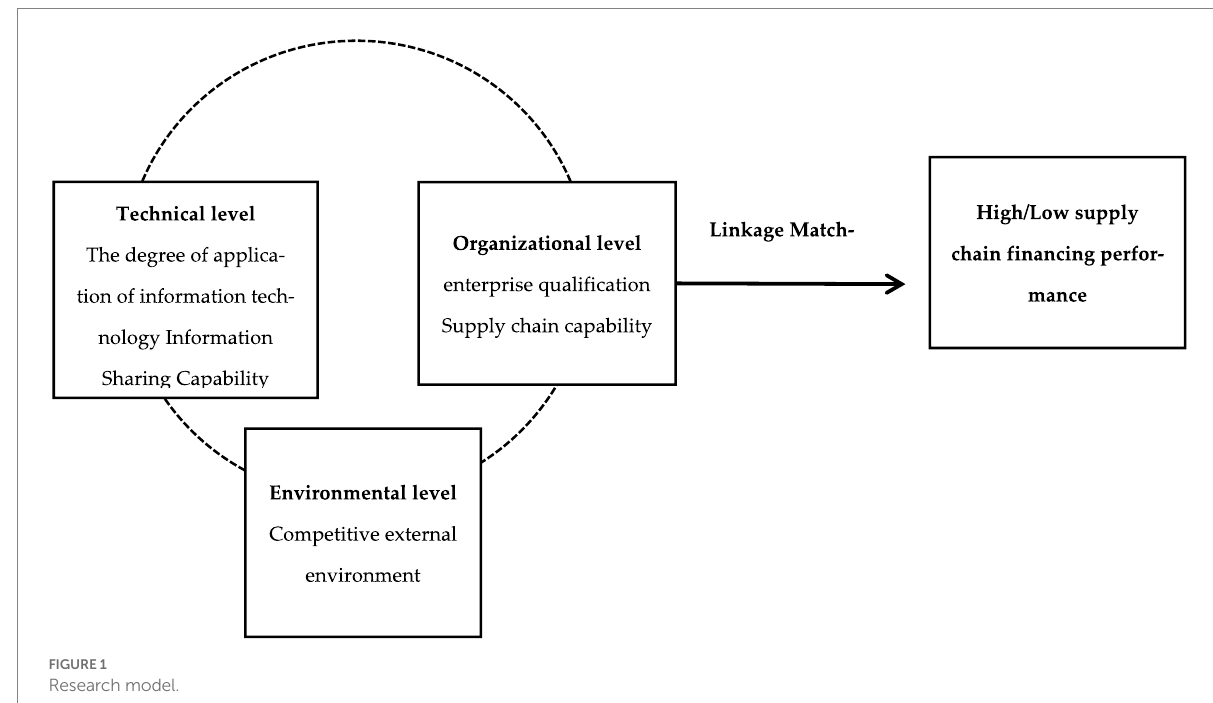
FIGURE 1 Research